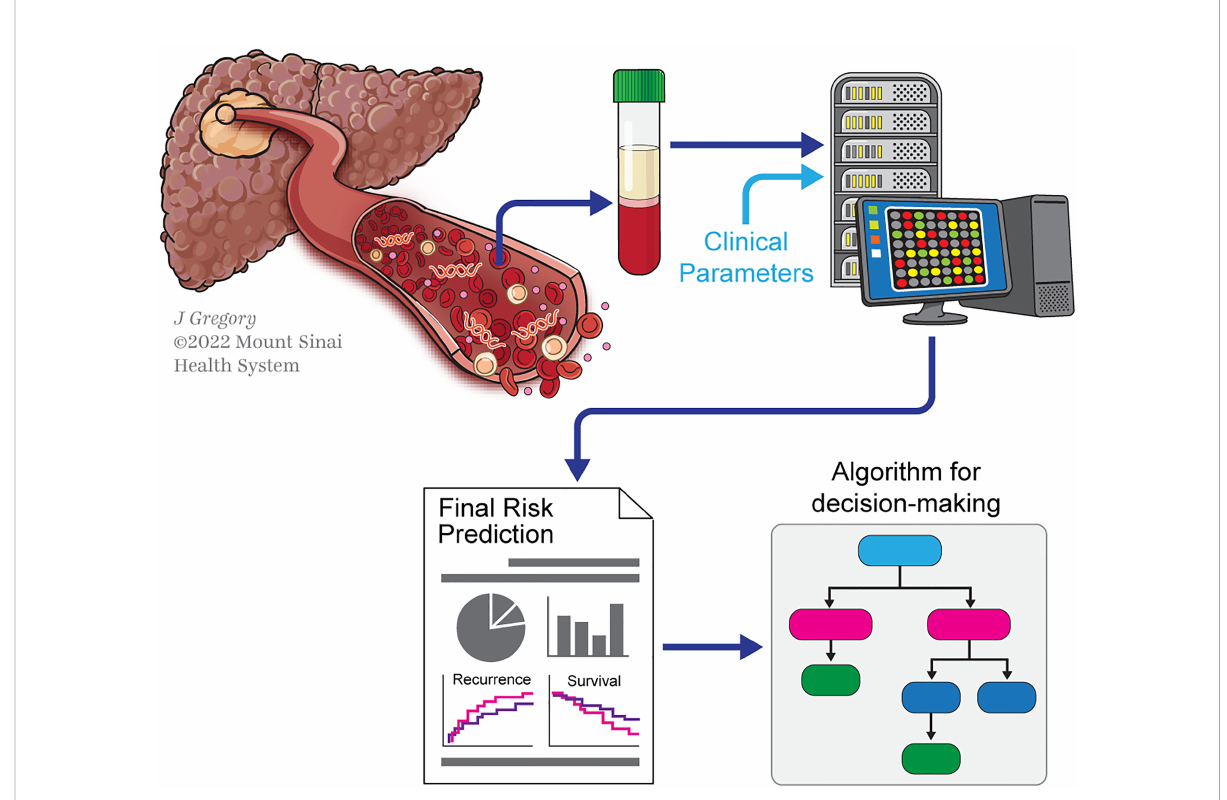
FIGURE 2 Scheme illustrating the potential contribution of liquid biopsy in decision-making for LT in HCC. Scheme illustrating a liquid-biopsy-based pipeline for decision-making in liver transplant (LT) for hepatocellular carcinoma (HCC). Collection of blood samples will allow detecting circulating analytes released by HCC into the bloodstream. Thereafter, these analytes are submitted to technologies like next-generation sequencing (NGS). The molecular analyzes of these by-products will help to determine prognosis (with outcomes such as recurrence and survival), which will ultimately guide decision-making to select patients for